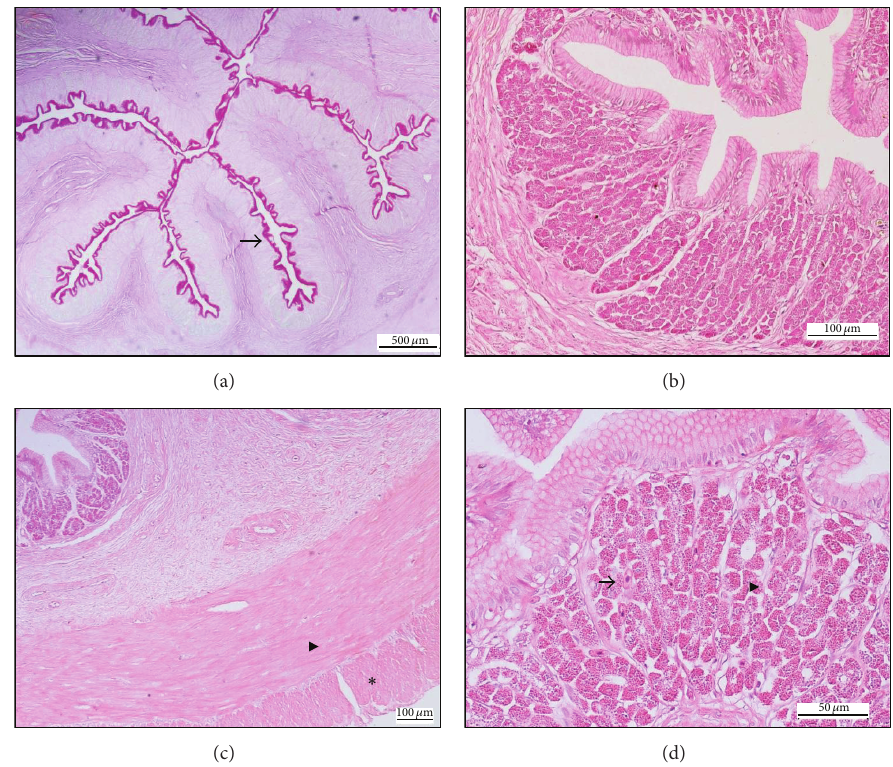
Figure 2: (a) Goblet cells (→) at the mucosal surface of stomach with glycogen positive stain, PAS 40x. (b) Short, sharp angle of mucosal projection of stomach, HE 200x. (c) Inner circular ( 󳶳 ) and outer longitudinal muscle of the stomach ( ∗ ), HE 40x. (d) Chief cells ( 󳶳 ) and parietal cells (→) at the gastric glands of stomach, HE